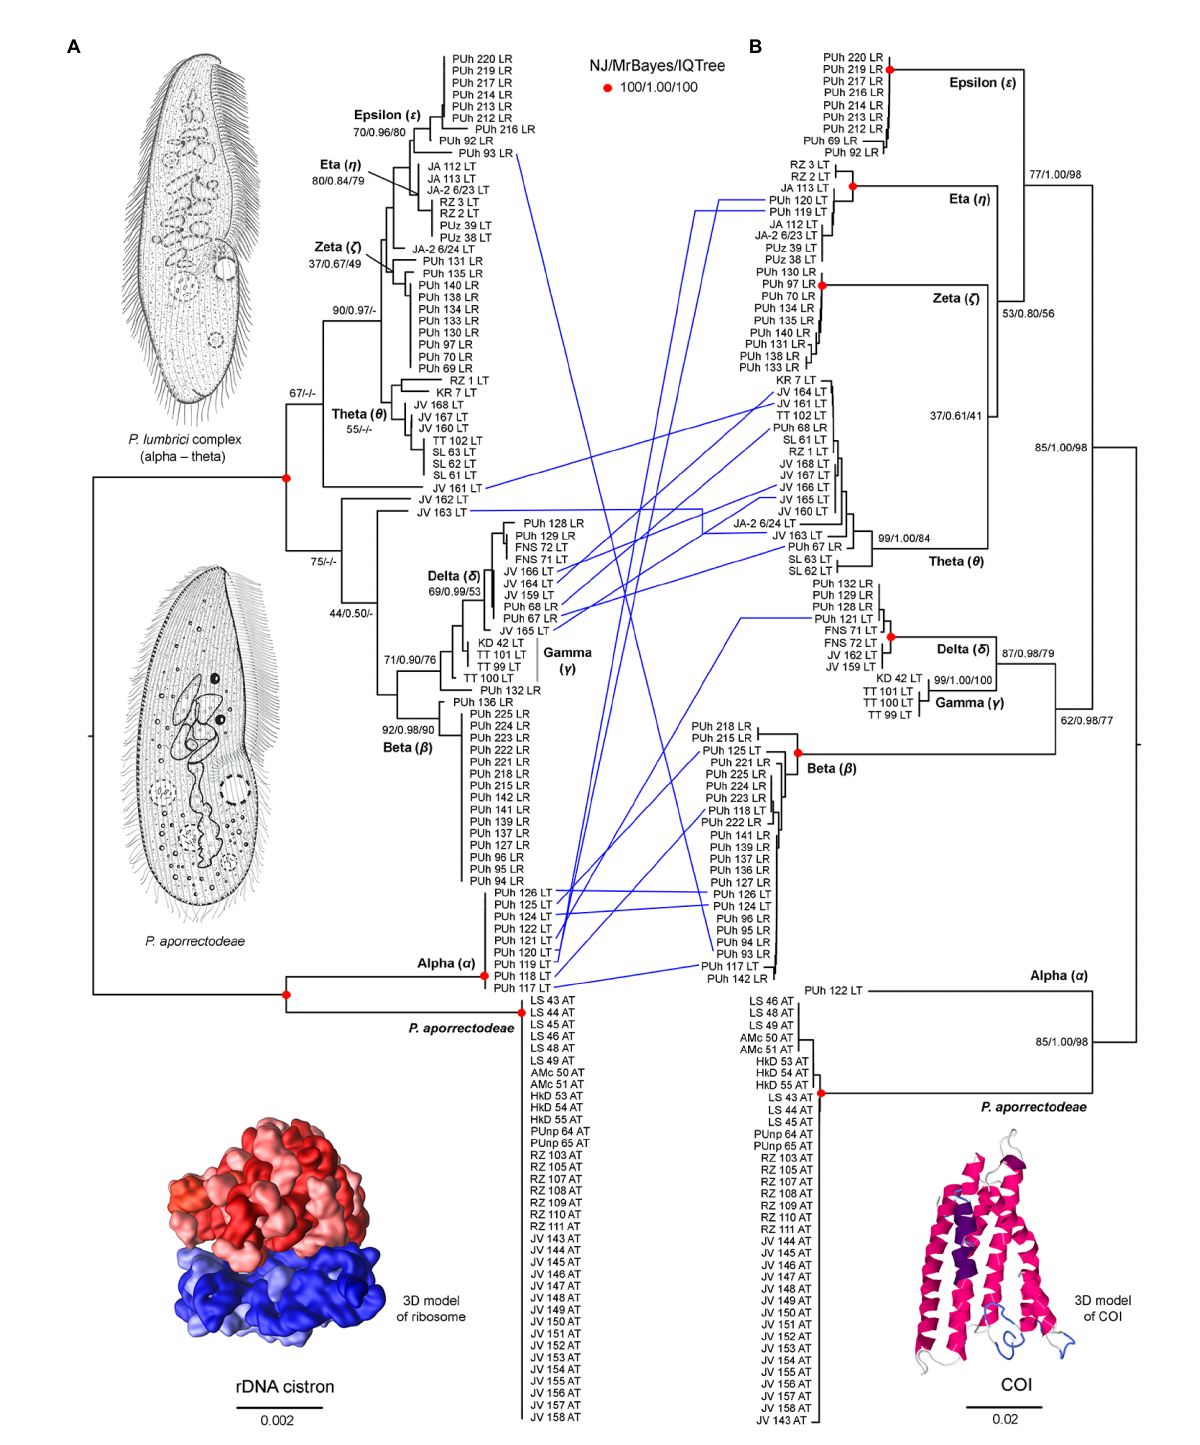
FIGURE 2 Tanglegram showing congruent and conflicting (blue lines) positions of plagiotomids in the rDNA cistron (A) and COI (B) trees. Bootstrap values for neighbor-joining (NJ) conducted in MEGA X and for maximum likelihood conducted in IQ-TREE as well as posterior probabilities for Bayesian inferences conducted in MrBayes are listed at corresponding nodes of the NJ trees. According to the present phylogenetic analyses, as many as nine distinct mitochondrial lineages were recognized within the isolated plagiotomids. One lineage represents a new homogenous and molecularly well-delimited species, P. aporrectodeae sp. n., while the remaining eight lineages belong to the highly heterogenous P. lumbrici complex (labeled by the first eight letters of the Greek alphabet from alpha to epsilon). Conflicting positions of hybrid specimens in the rDNA cistron and COI gene trees are marked by blue lines. For specimen codes and further details, see Supplementary Table S1. Scale bars denote the fraction of substitutions per site. The 3D model of the ribosome is available under the CC BY-SA 3.0 license (Author: Wossman), while the 3D model of COI was constructed using Jmol ver.